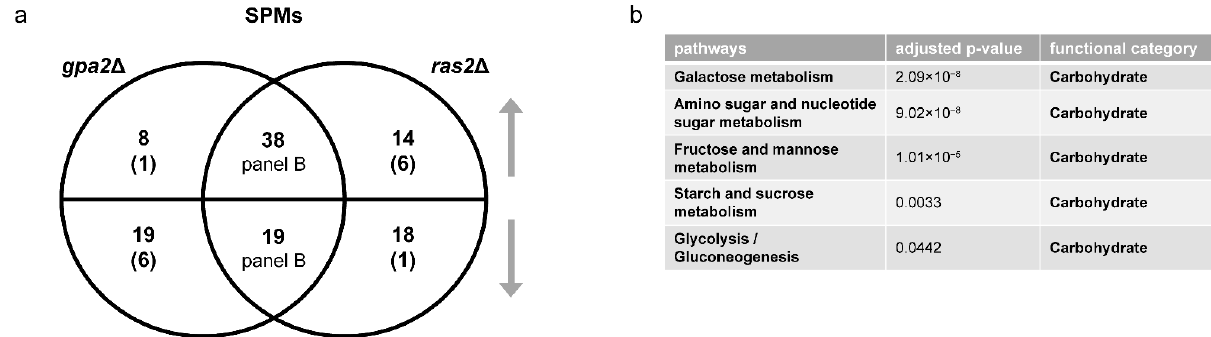
Figure 6. Comparing significantly perturbed metabolites (SPMs) of gpa2 Δ and ras2 Δ . ( a ) Venn diagram of subsets of SPMs, for gpa2 Δ and ras2 Δ vs. wildtype, after glucose addition. Upper semicircle shows up-regulated SPMs and lower semicircle shows down-regulated SPMs. Numbers in the overlapping region are shared SPMs regulated in the same direction. Numbers in parenthesis are shared SPMs regulated in the opposite direction, and are placed in the area corresponding to the direction of regulation. SPMs used for ORA analysis that are ( b ) shared and change in the same direction. Listed are all pathways and their functional categories with adjusted p -value < 0.05.